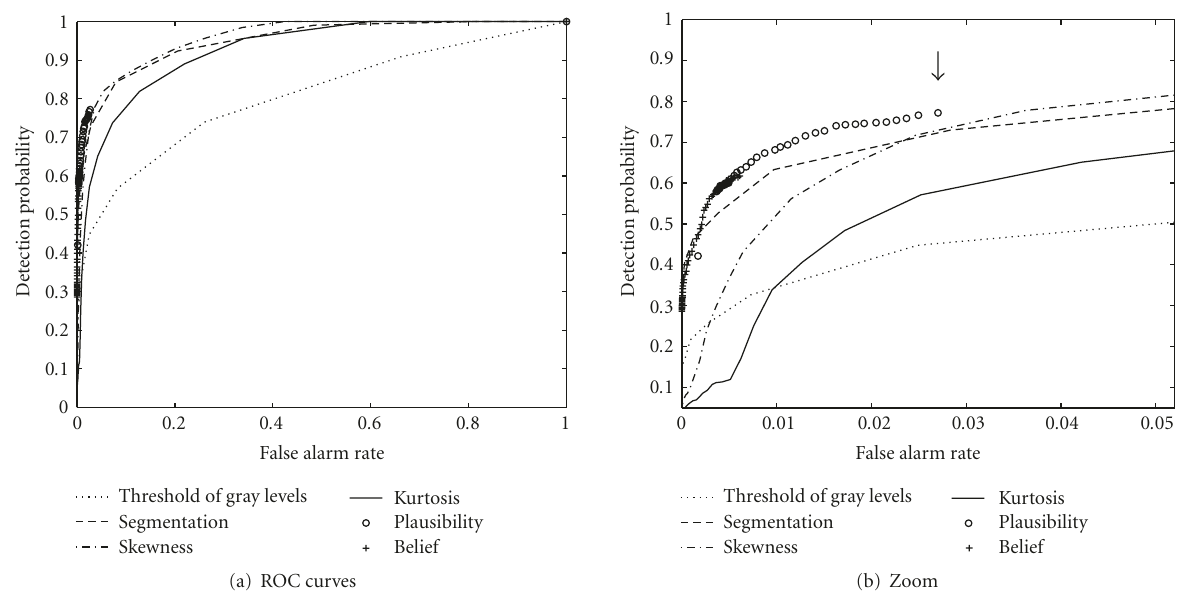
Figure 19: ROC curves of each of the three parameters compared with the results of the fusion process (belief and plausibility) in image 1.